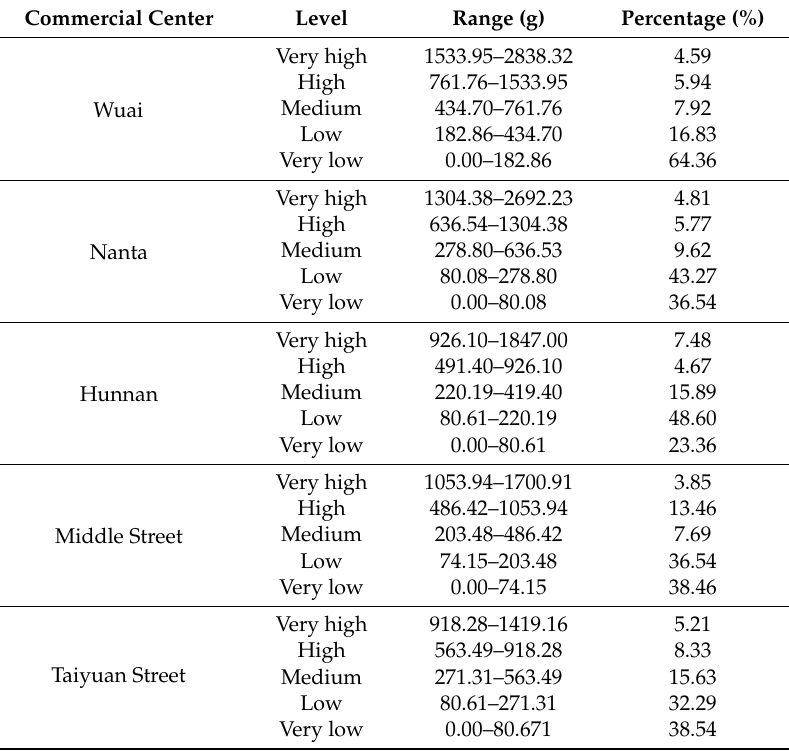
Table 4. Emissions data for the eight commercial centers.